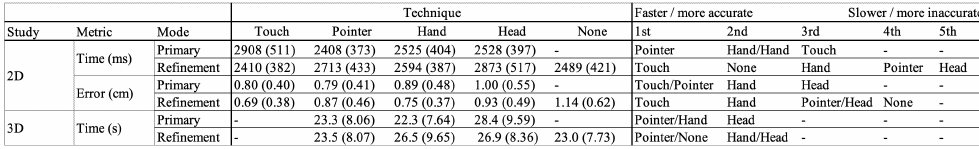
Figure 5. The study results containing the times and errors for the different interaction techniques in primary as well as refinement